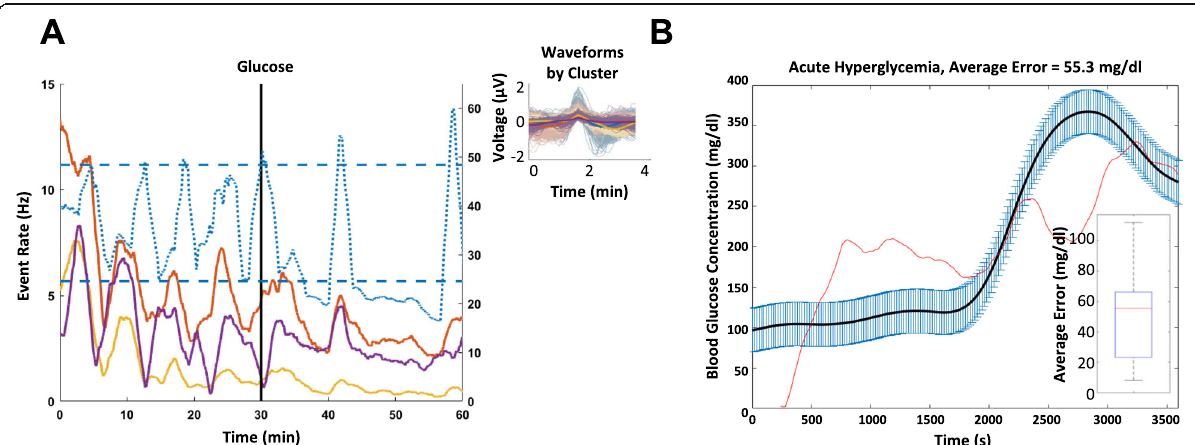
Fig. 6 An example of neural responses to a glucose injection. Each colored trace represents the response rate against time of a different CAP – solid lines correspond to lower firing rate CAPs (maximum of 15 CAPs/sec) and dotted lines corresponds to high firing rate CAPs (maximum of 60 CAPs/sec). The injection is indicated by a vertical black line occurring at 30 min. The thresholds encapsulating the baseline statistics of a particular CAP are indicated by horizontal lines of the same color. The a glucose VN response curves include a CAP that decreases its firing rate are shown here along with their respective waveforms. An example of wild type b regression model performance from a glucose injection. The black line indicates the smoothed blood glucose measurements, with blue bars indicating interpolation error. The red line indicates the estimated blood glucose levels as an output of the regression model. The regression revolves around the smoothed blood glucose measurements, and the average error over the N = 6 subjects has an interquartile range between 25 and 66